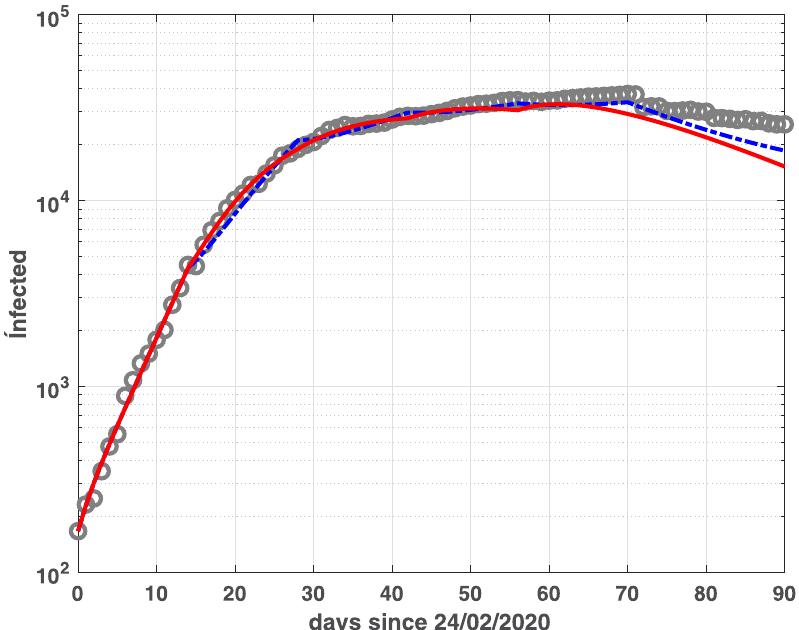
Fig 4. Infected compartments for Lombardia. Infected data (gray circles) and infected modelled population, obtained by fSEIRDr (blue dash-dotted line) and fSEIDRe (red continuous line) for Lombardia.